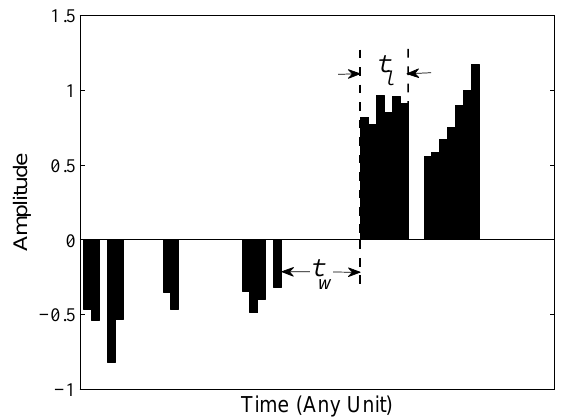
Fig. 4. Schematic diagram of extreme time series. Waiting time t w